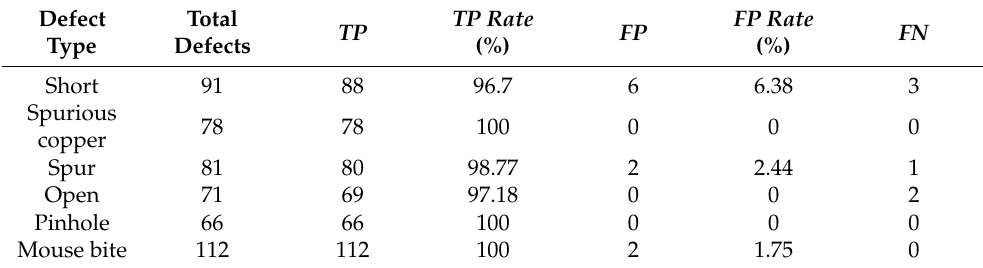
Table 1. Circuit board detect